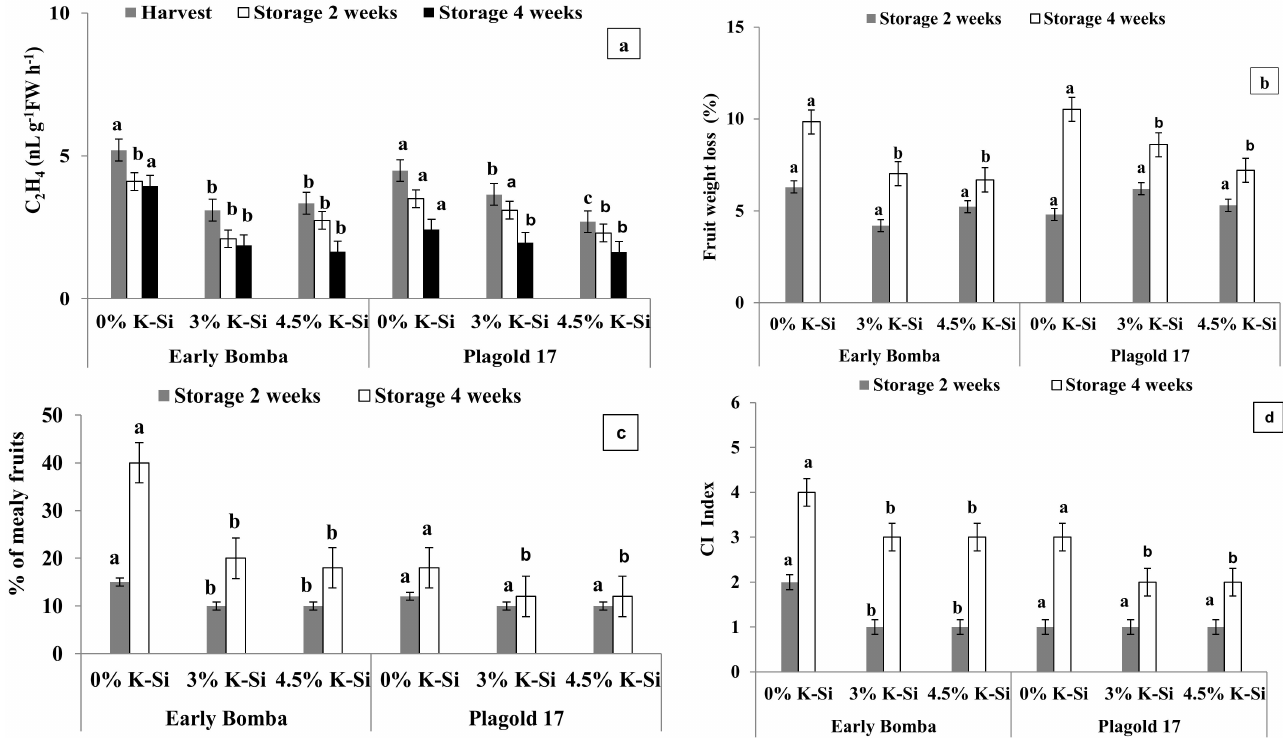
Figure 5. Impact of the potassium silicon spray and storage period on ethylene ( a ), fruit weight loss ( b ), mealiness ( c ) and chilling injury index ( d ) in peach cultivars after storage at 5 ◦ C for 2 and 4 weeks and then ripening at room temperature for 2 days. Units and abbreviations: CI (CI index) was visually assessed according to the global fruit appearance of each genotype, from healthy fruit with no symptoms (1) to extremely injured fruit with severe CI symptoms (6). Values are means (n = 3) ± SE. Letters a, b, c letters indicate difference ( p < 0.05) among K-Si treatments after 2 weeks of cold storage according to Scheffe’s multiple range